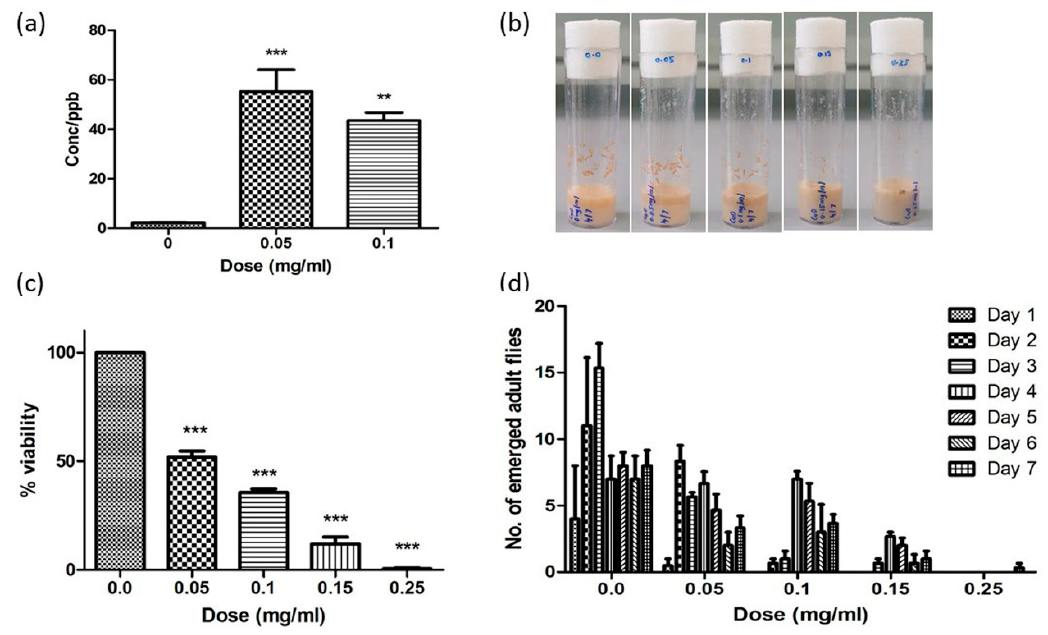
Figure 2. CuONP ingestion induces toxic effects in Drosophila . ( a ) CuONP-fed F1 progenies show an uptake and accumulation of CuONPs in the body. ( b , c ) A dose-dependent decline in the number of pupa and in egg-to-adult survivorship is observed upon CuONPs. ( d ) CuONP exposure causes a dose-dependent delay in development. Error bar = SEM, * p -value < 0.05; ** p -value < 0.01; *** p -value < 0.001.